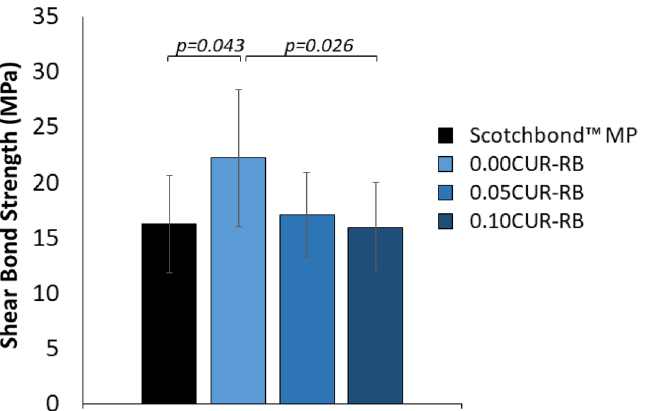
Figure 3. Shear bond strength to dentin as a function of curcumin concentration. Scotchbond MP served as a study commercial control. Data reported as average (MPa) ± one standard deviation (n = 12). Horizontal bars indicate statistically detectable differences (p < 0.05).